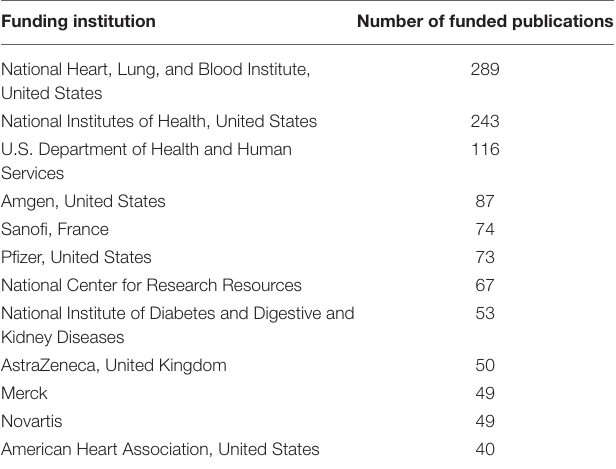
TABLE 2 | Most prolific funding